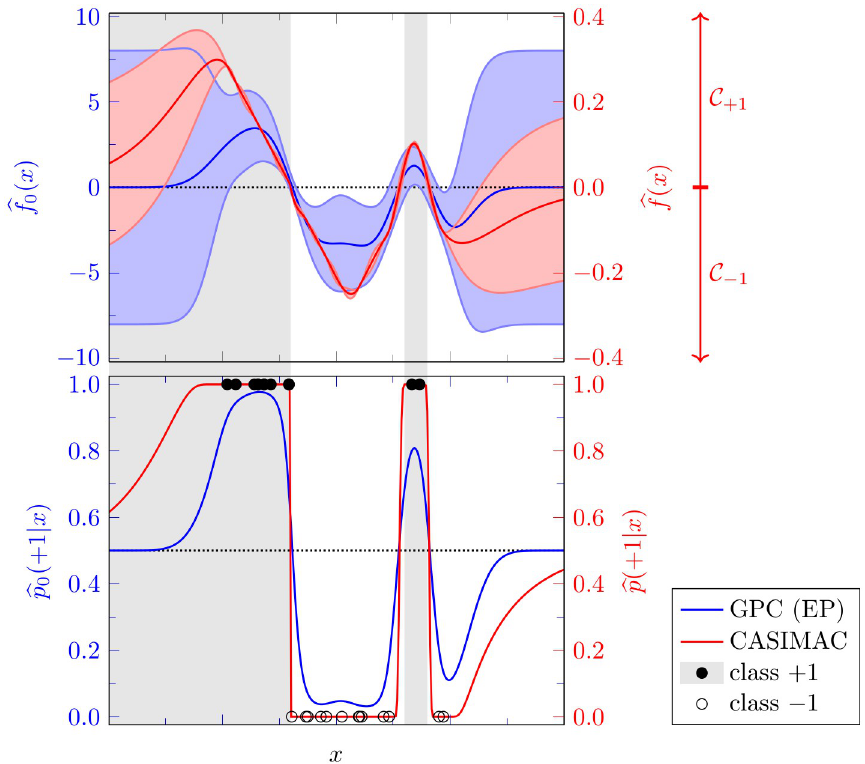
Fig 1. Exemplary binary classification problem. An exemplary binary classification problem with one-dimensional feature space X ¼ R and class labels y 2 { − 1, +1}. We compare a GPC (using a radial-basis-function kernel and expectation propagation (EP) with the implementation from [19]) and our CASIMAC (based on a GPR with Mate´rn kernel as the underlying regression model), both trained on the same D = 25 training datapoints. The top plot shows the expectation values ^ f ð x Þ , ^ f ð x Þ and the standard deviations of the latent space distributions ^ q 0 both approaches (on two different scales), whereas the bottom plot contains the class probability predictions ^ p and ^ p ðþ 1 j x Þ for both approaches. The gray and white areas indicate the true regions of the class + 1 and − 1, respectively. All datapoints are sampled without noise from these regions. Finally, the dotted horizontal lines ( ������������� ) represent the decision boundaries. The corresponding cone segments for CASIMAC, C ¼ ½ 0 ; 1Þ , are shown in the top C þ 1